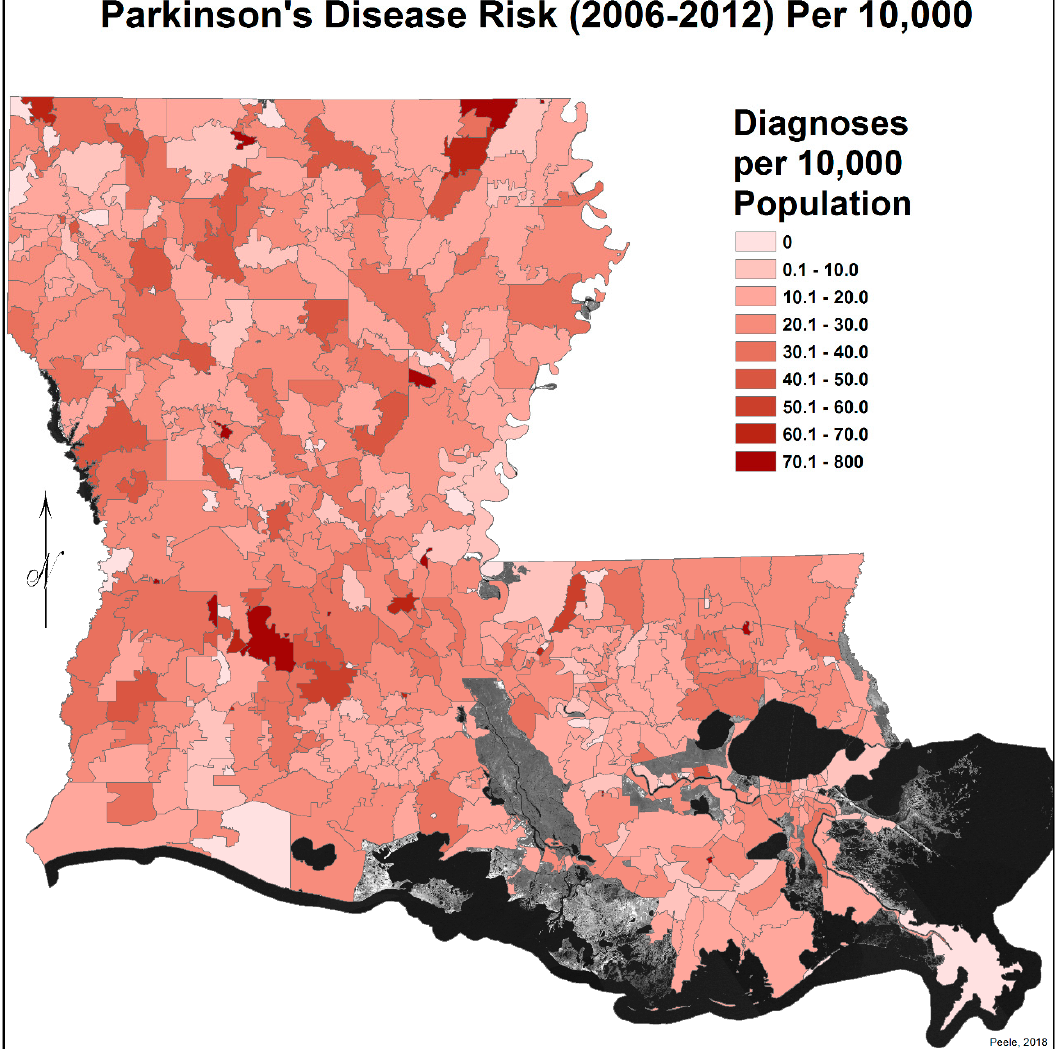
Figure 2. Parkinson’s disease risk for 2006–2012 per 10,000 persons by Louisiana ZIP